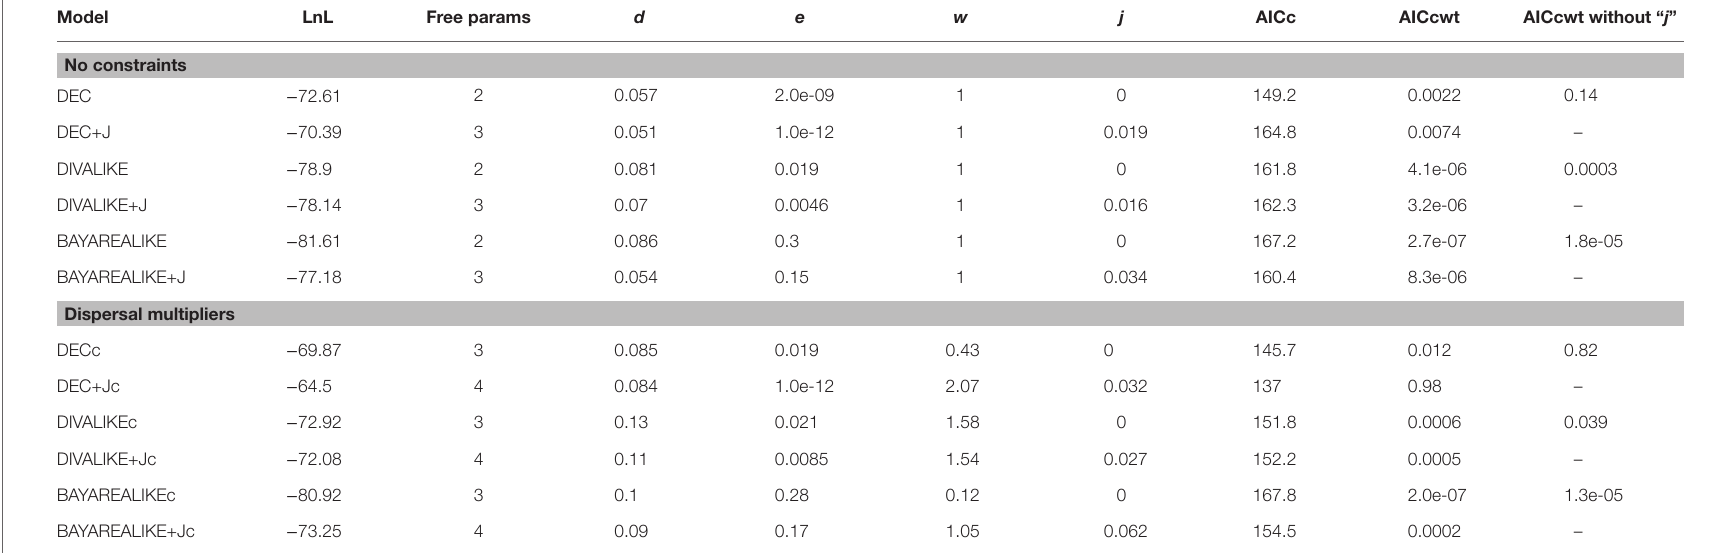
TABLE 1 | Biogeographical models tested in BioGeoBEARS (Matzke, 2013) for Centaurium .